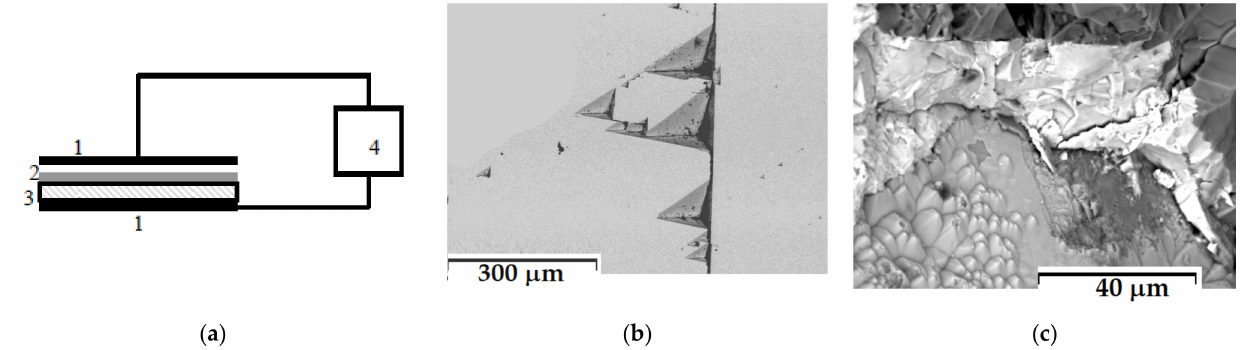
Figure 7. ( a ) Schematic representation of a cell of a dielectric barrier discharge: 1—flat metal elec- trodes of plate form, 2—layer of the ground mineral, 3—plate of dielectric, 4—high voltage power supply. Reprinted with permission from Ref. [125]. Copyright 2019, Andreev V.V. ( b ) Galena and ( c ) perovskite surface after treatment by DBD ( t treat = 50 s). SEM; scale bars: ( b ) 300, ( c ) 40 µ